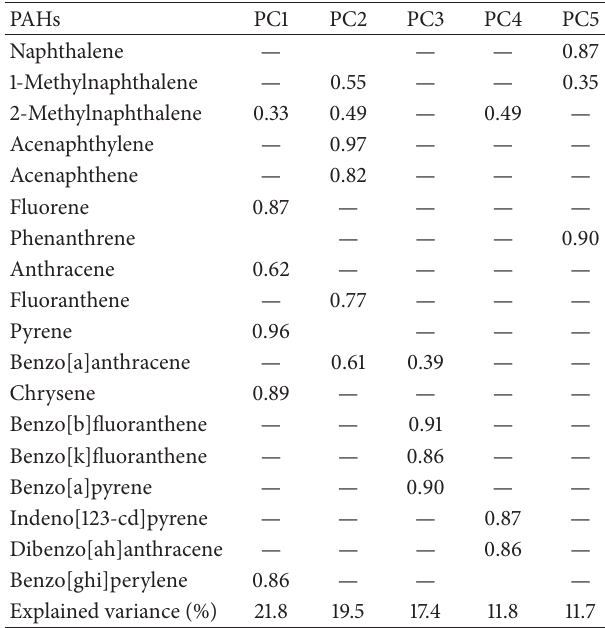
Table 7: Rotated component loadings of the principal components (PCs) for PAH composition in the sediment of Langkawi